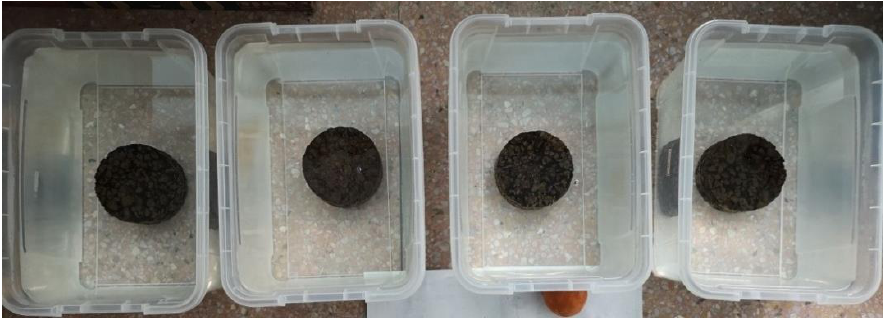
Figure 3. PAC-13 specimens with and without a municipal solid waste incineration-bottom ash aggregate (MSWI-BAA) used in the simulated leaching experiment.